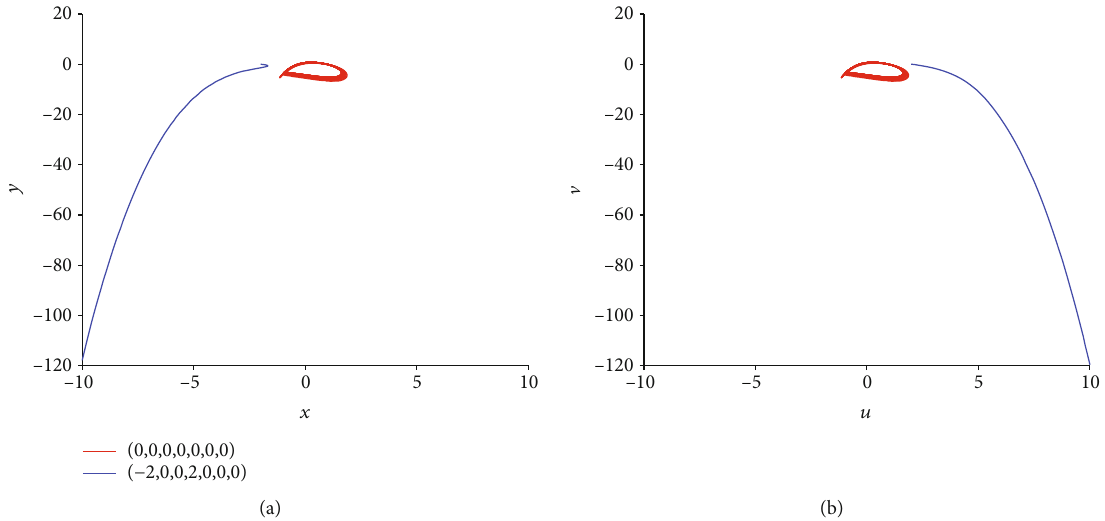
Figure 16: Coexistence of multiple fi ring patterns dependent on initial values for k = 0 : 5 and I value ð 0, 0, 0, 0, 0, 0, 0 Þ while the blue one is for ð − 2, 0, 0, 2, 0, 0, 0 Þ